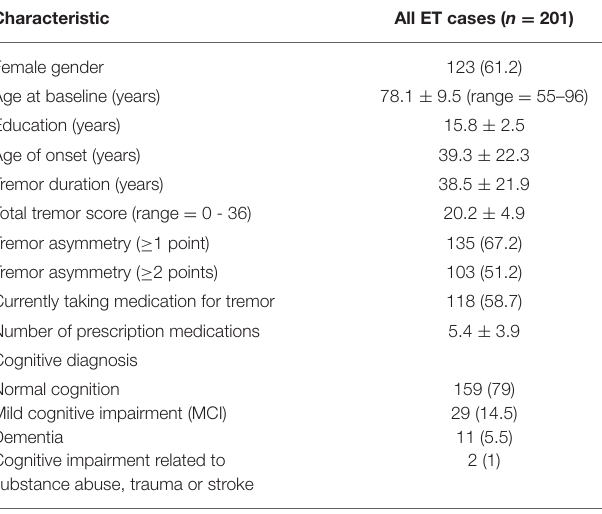
TABLE 1 | Baseline demographic and clinical characteristics of 201 ET